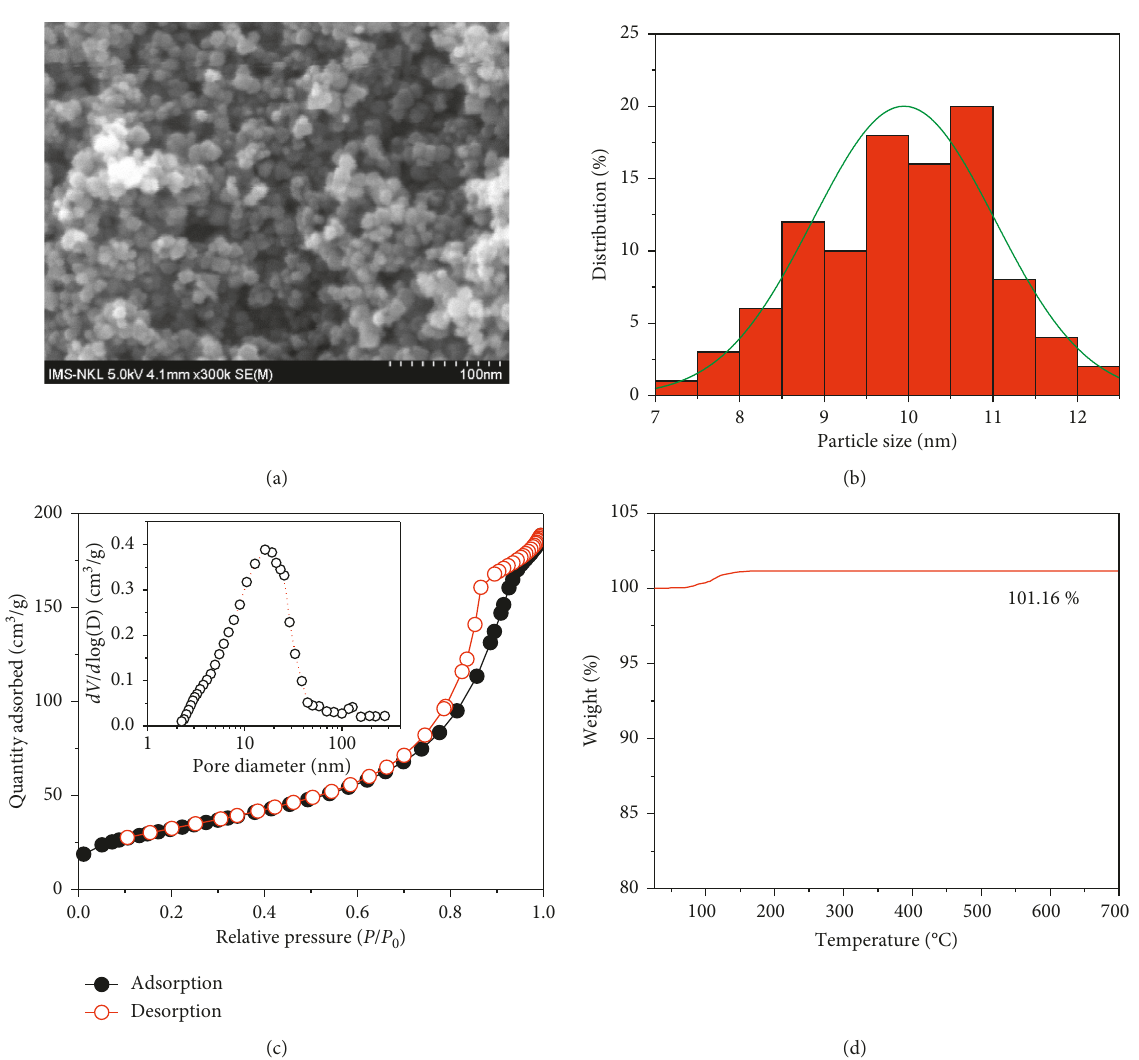
Figure 3: (a) FE-SEM image; (b) particle-size distribution; (c) N 2 adsorption/desorption isotherms; (d) thermogravimetric analysis (TGA) of synthesized Fe 3 O 4 . Inset in Figure 3(c) shows the pore size distribution calculated from the Barrett–Joyner–Halenda (BJH) formula of synthesized Fe 3 O 4